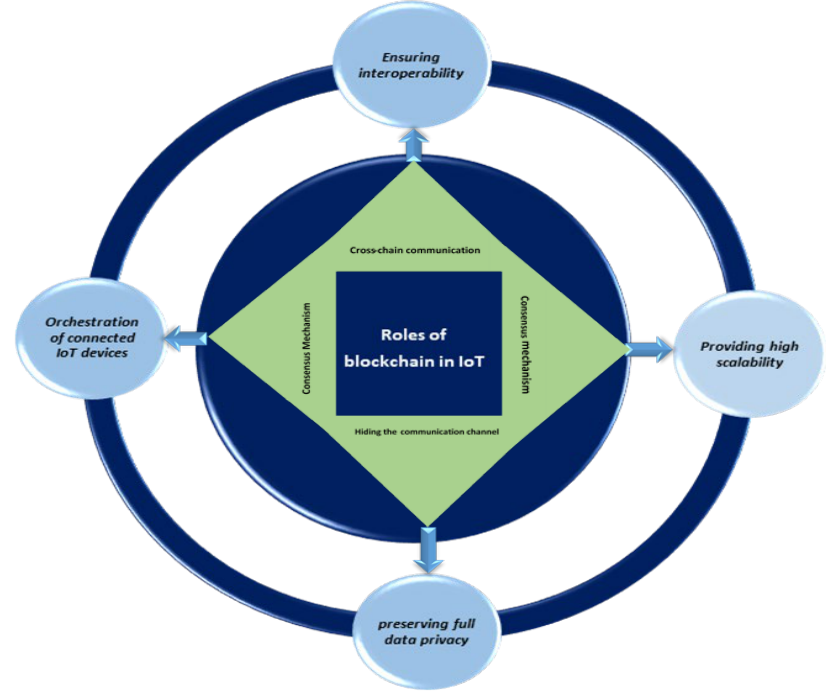
Figure 2. The role of blockchain in IoT